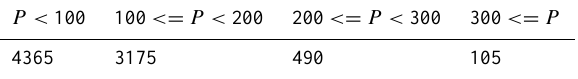
Table 1. Distribution of the number of rain gauge stations per inter- val of maximum daily precipitation (mm).